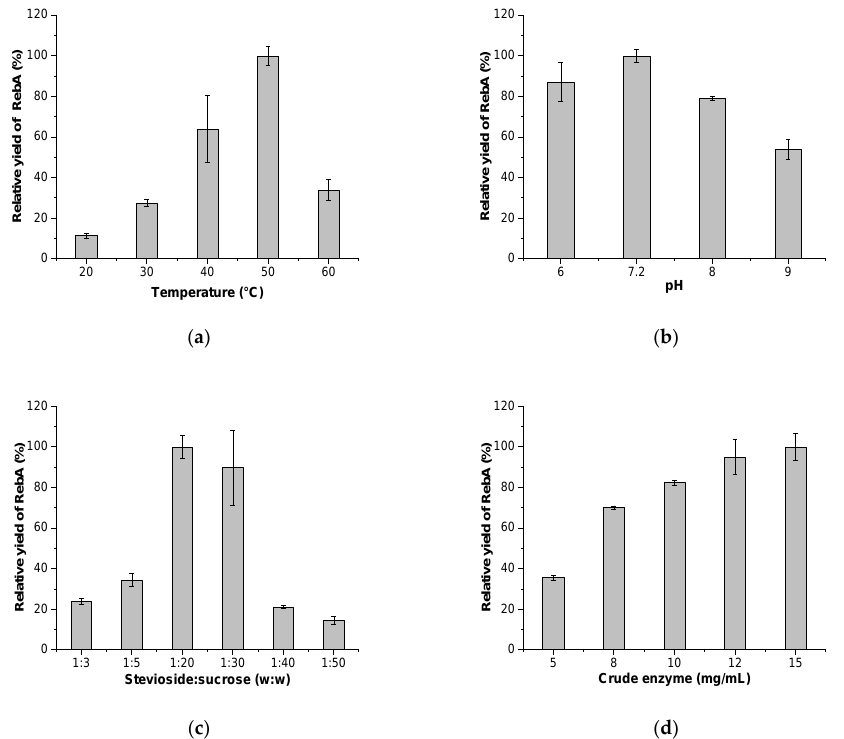
Figure 3. Effects of temperature ( a ), pH ( b ), substrate ratios ( c ), and crude enzyme concentrations ( d ) on RebA synthesis catalyzed by Acm-R3-76G1.